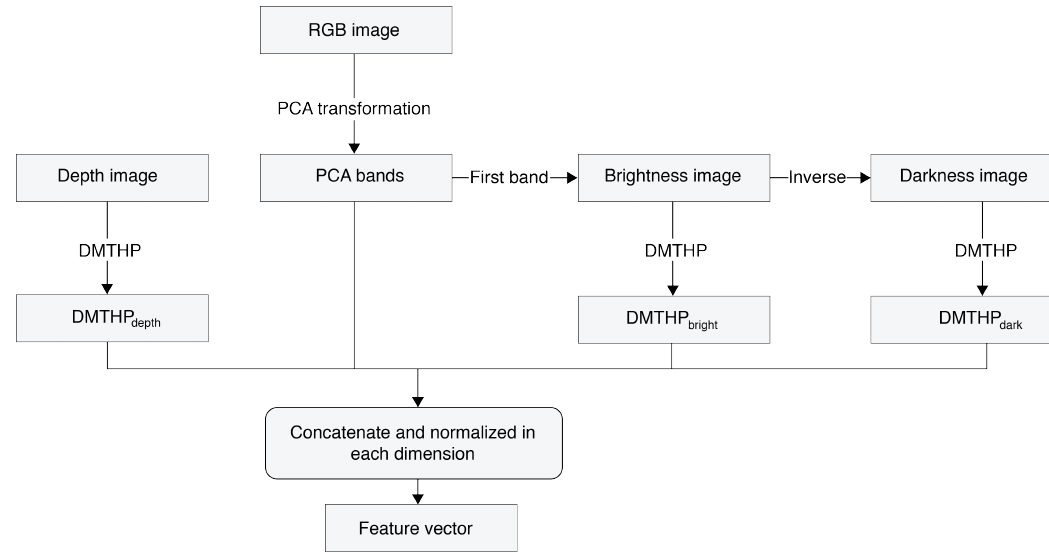
Figure 2: The feature extraction diagram using PCA and DMTHP.